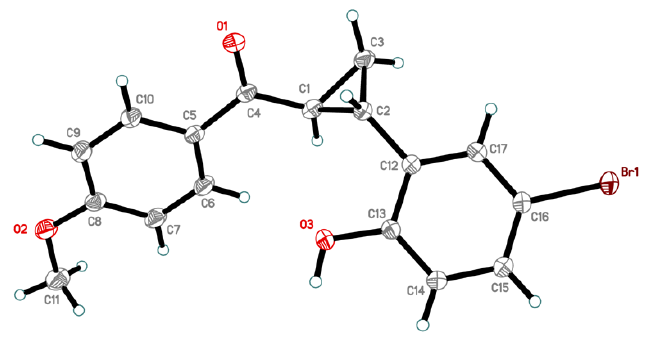
Figure 1. Single ‐ crystal X ‐ ray data for compound 2e (CCDC 2042862). Figure 1. Single-crystal X-ray data for compound 2e (CCDC